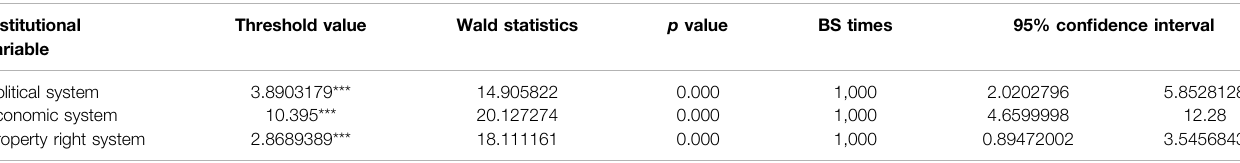
TABLE 2 | Self-sampling test of dynamic threshold